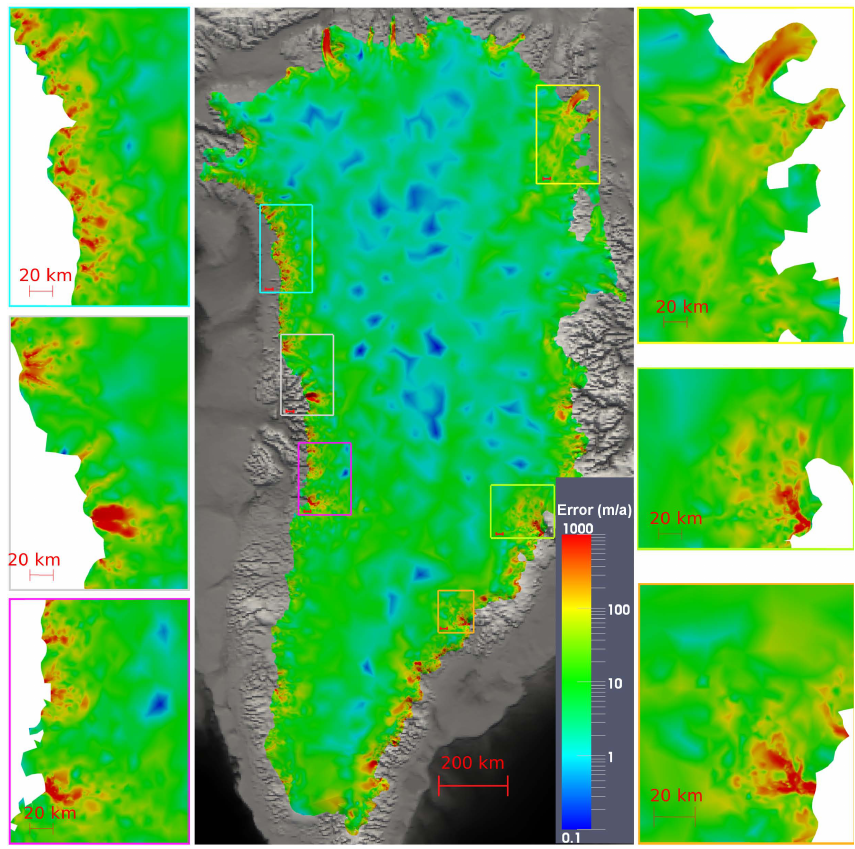
Fig. 4. Absolute error on surface velocities | u mod − u obs | in ma − 1 at the end of the optimisation using the Robin inverse method.